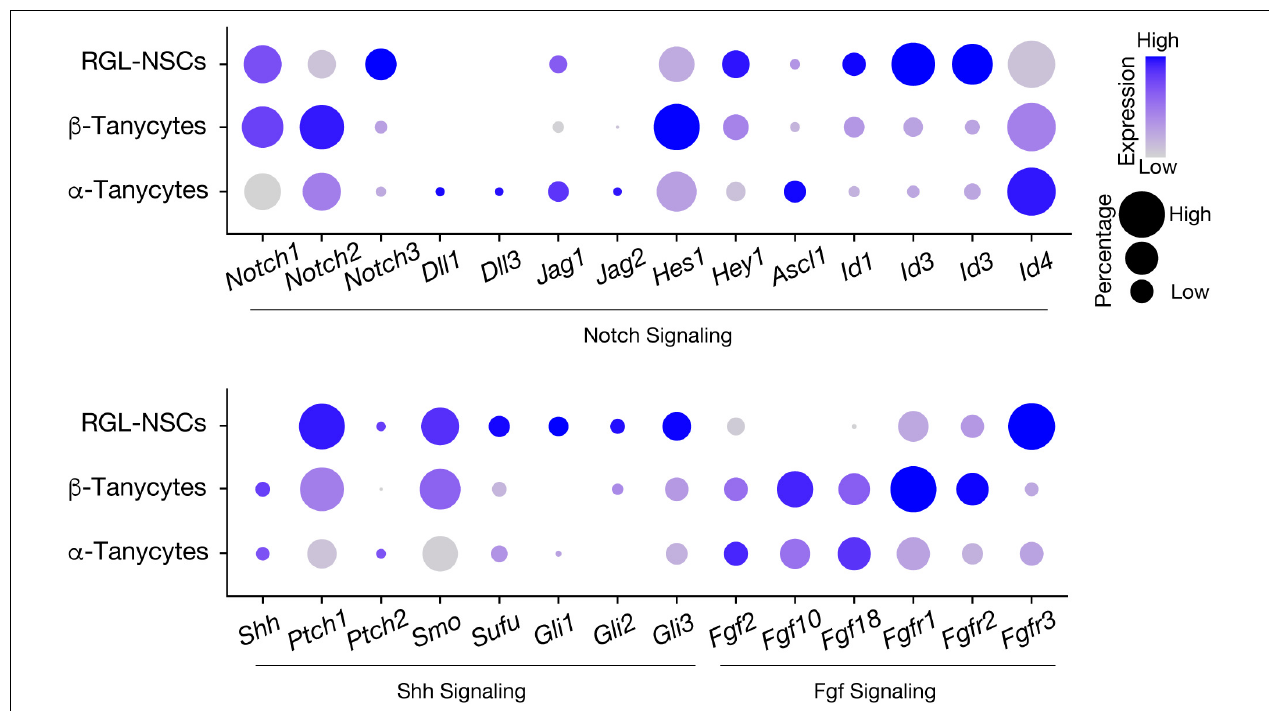
FIGURE 6 | Expression of signaling pathway genes involved in neural stem cell activation in hypothalamic RGLs. Expression of Notch, Shh, and Fgf pathway-related genes in RGL-NSCs, α -tanycytes, and β -tanycytes from the Ins2-Cre ;Ai14 tdTomato scRNA-seq dataset. The size of the dot indicates the percentage of cells expressing a specific gene in each cluster, and the color represents the average expression level of the